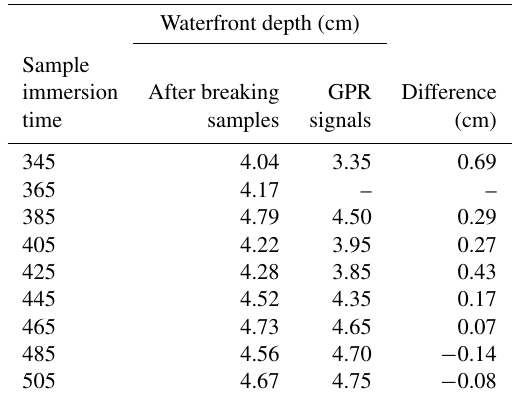
Table 3. Waterfront determination by means of GPR